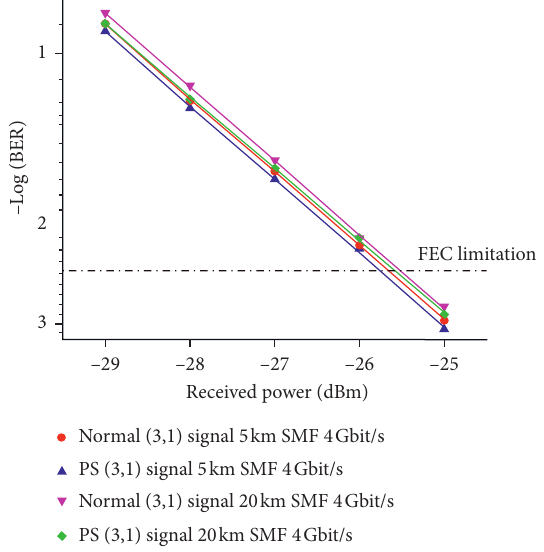
Figure 7: BER of the normal (3, 1) signal and the PS (3, 1) signal versus received optical power for 5 km and 20km SMF trans- mission at 4Gbit/s,